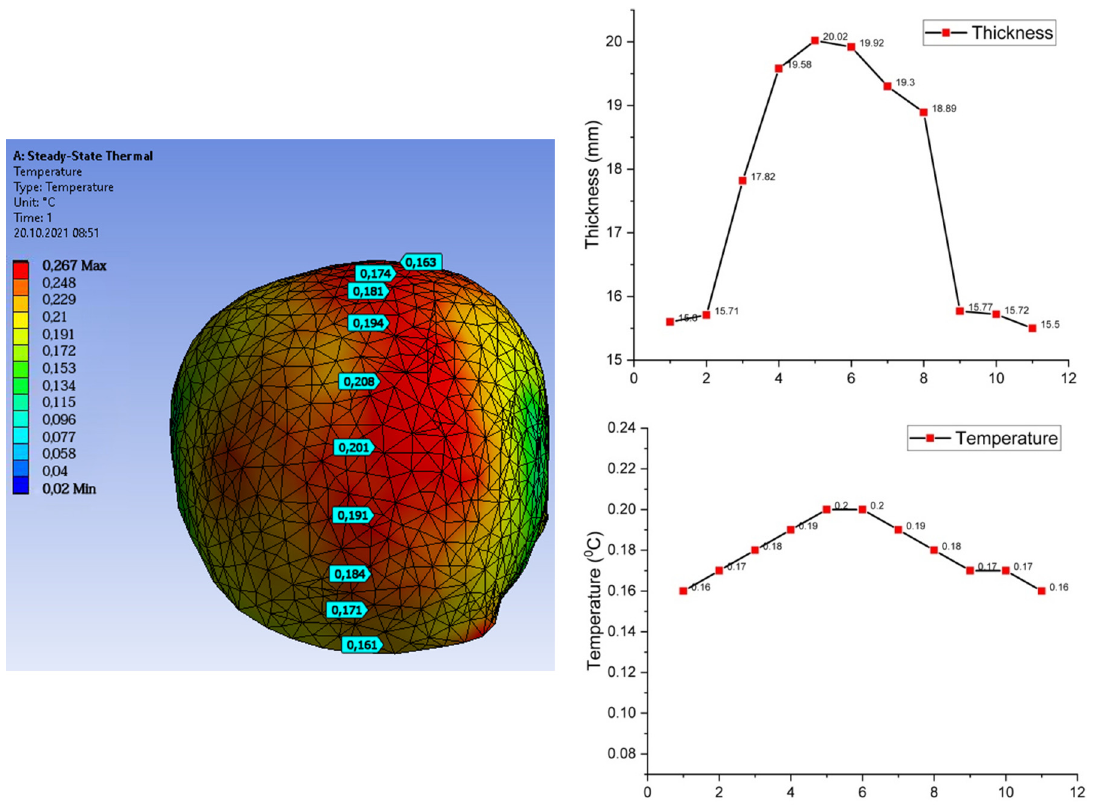
Figure 15. Temperature and thickness values along the frontal and occipital bones (i.e., second curve). For the purpose of comparison with the proposed method based on thermal analysis, the Ray-Triangle method [44,45], which is able to calculate the thickness in 3D objects, was applied to the manuscript data. Random points were selected along the geometric curve drawn from the frontal bone to the parietal bone and the geometric curve drawn from the left temporal bone to the right temporal bone. First, the coordinate values of the selected points in 3D space were recorded. The Ray-Triangle method was used to pass through these points. The skull thickness values obtained by the Ray-Triangle method are shown in Figure 16. The skull thickness values of the proposed method and the Ray-Triangle method were compared.